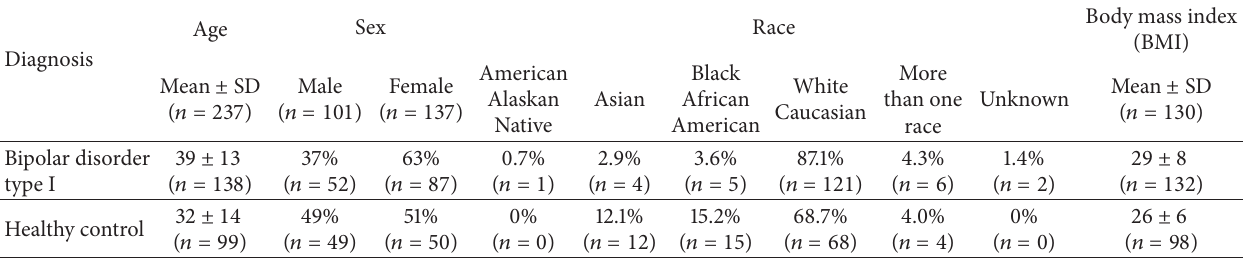
Table 1: Here we provide demographic and anthropometric information on study volunteers.